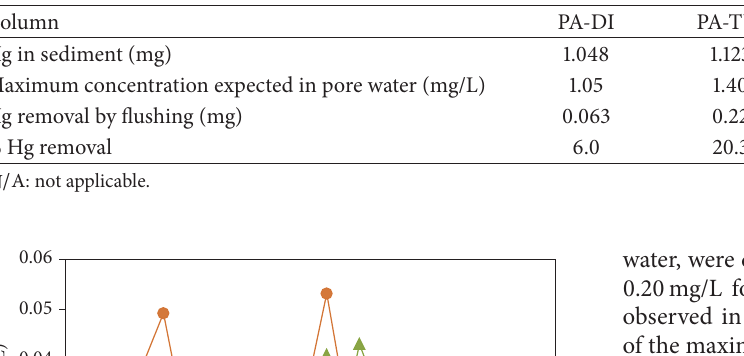
Table 4: Hg removal efficiency by flushing.